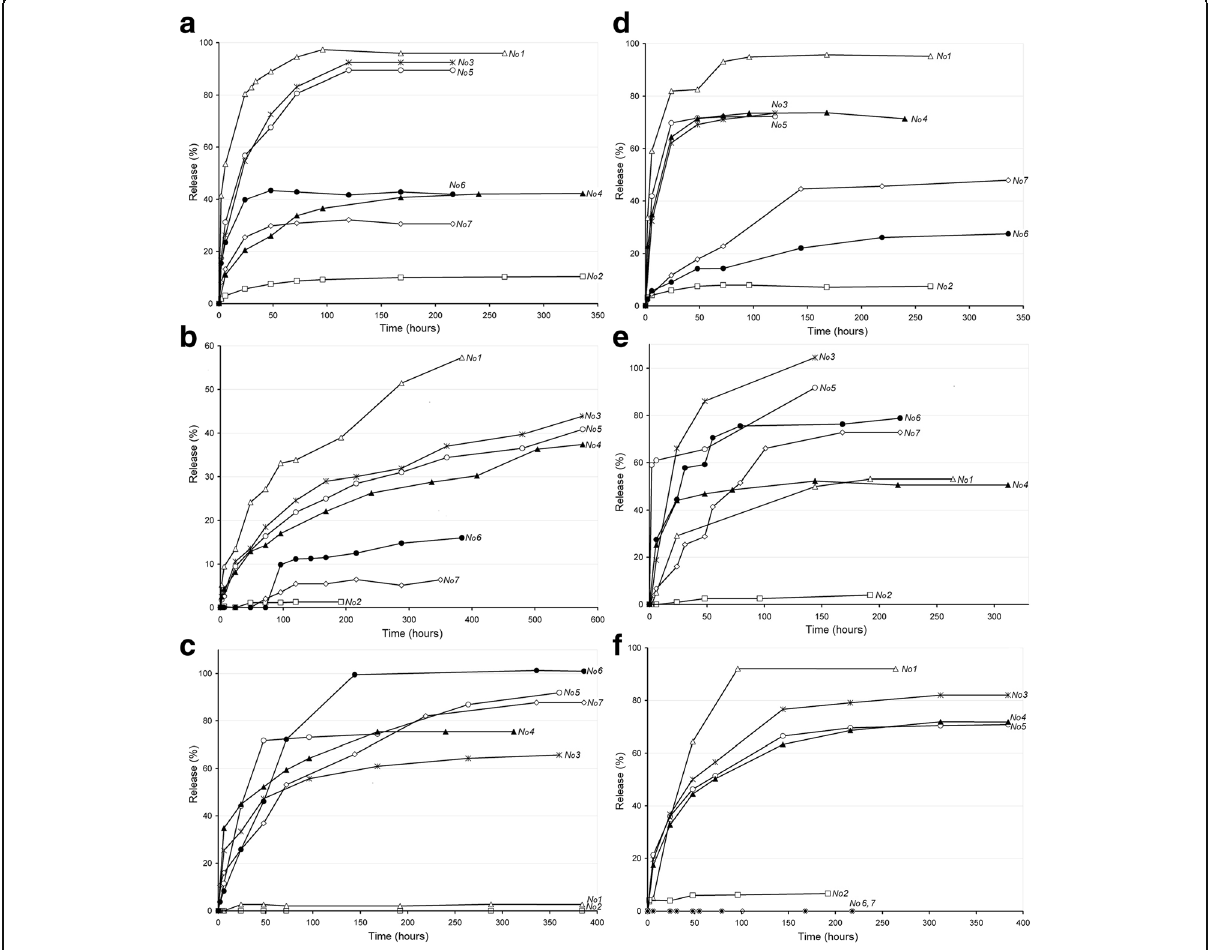
Fig. 6 BAC release kinetics from nanocomposites: a ) metronidazole, b ) decamethoxin, c ) Zn 2+ , d ) Ag + , e ) glycine and f ) tryptophan. Curve